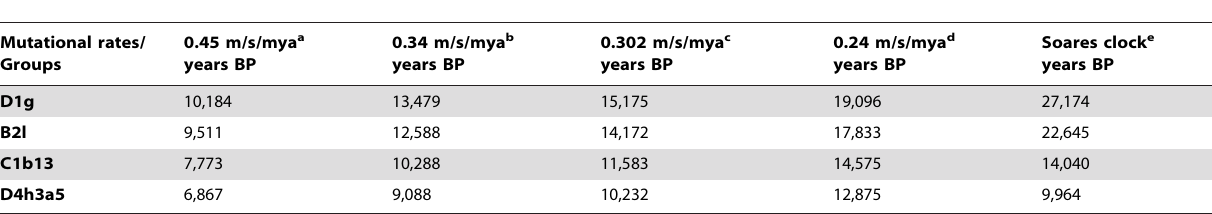
Table 1. Comparison of the coalescence ages calculated using different mutation rates.